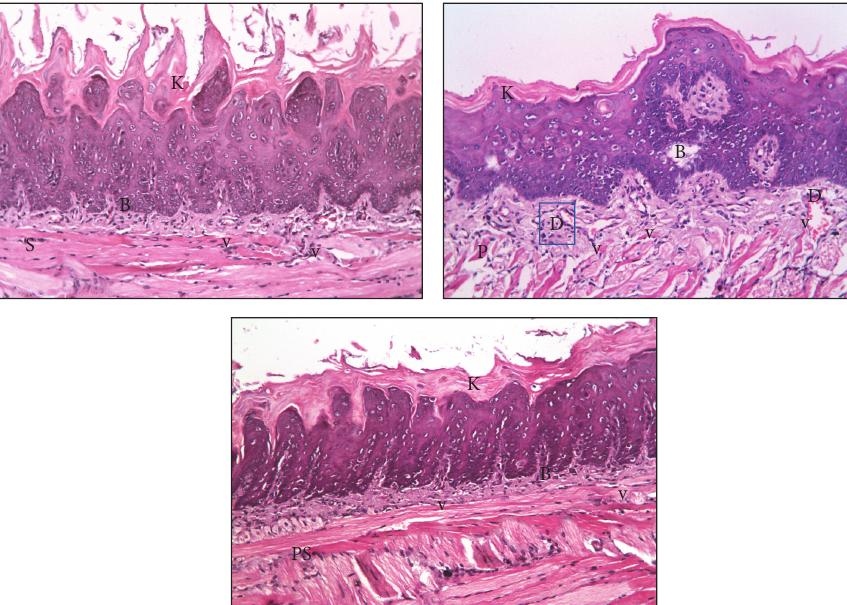
Figure 5: Photomicrographs of the dorsal surface of the tongue of the treated groups [(S) irradiation + MSCs, (P) irradiation + PRP, (PS) irradiation + MSCs + PRP] at 7 days following radiation showing (B) preserved basal cell architecture, (K) preserved keratin tips over the lingual papillae, (v) blood vessels, and (D) dilated engorged blood vessel (H&E, ×